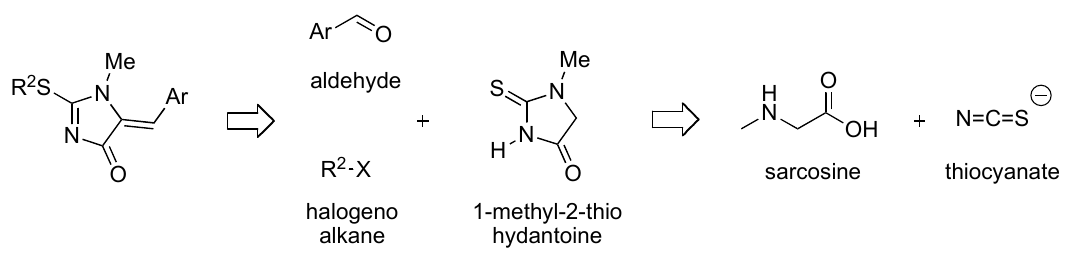
Figure 2. Components used for the synthesis of 2-alkylthio-5-arylmethylene-1-methyl-1,5- dihydro-4 H -imidazol-4-ones.